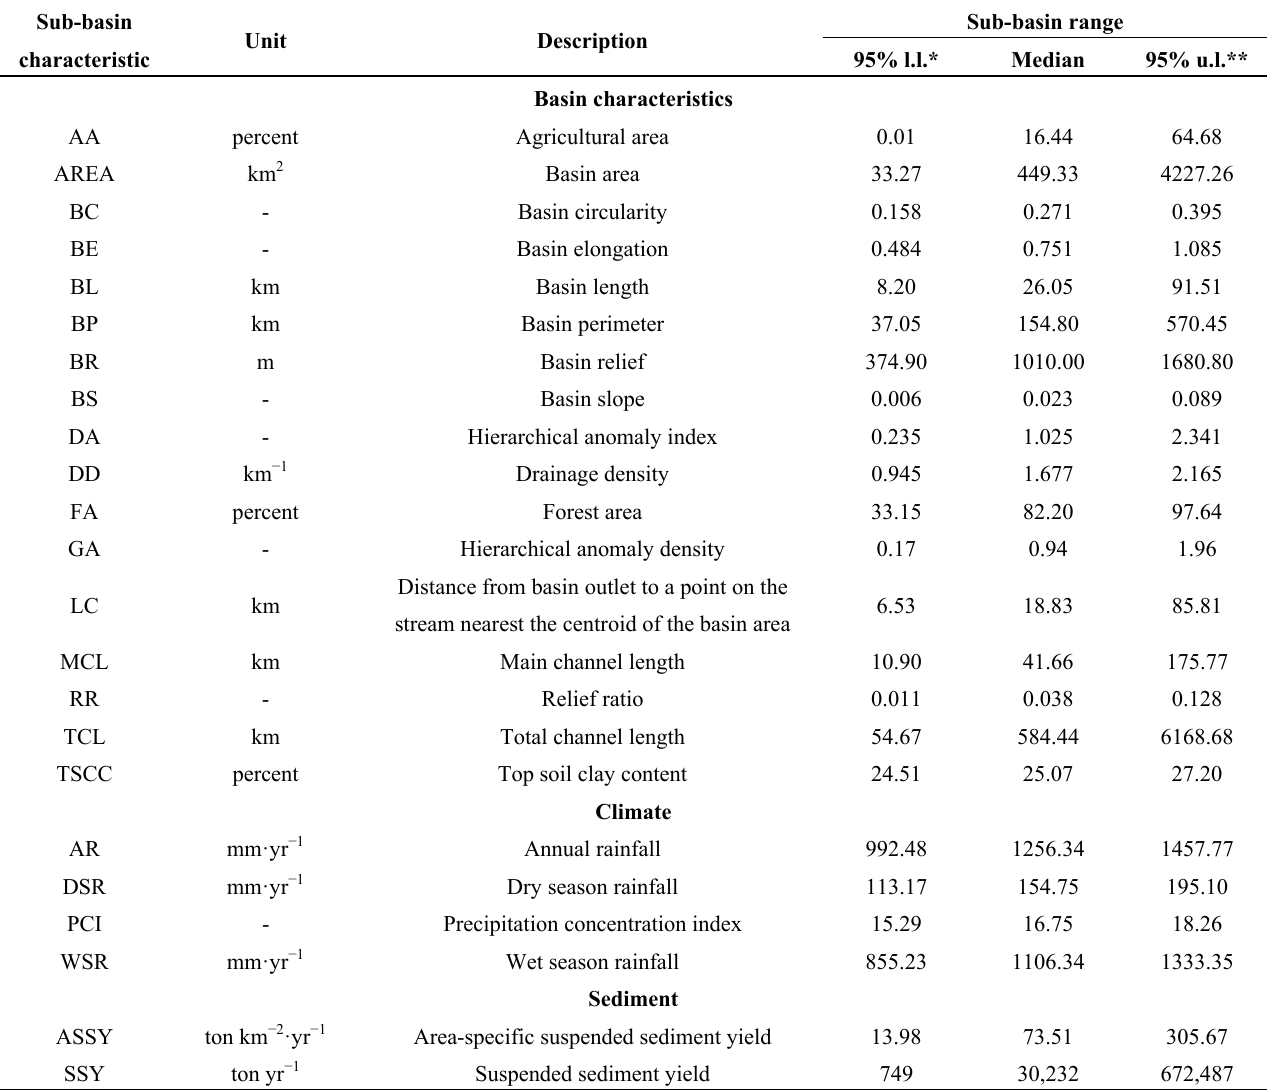
Table 3. Glossary and summary statistics for the sub-basin’s